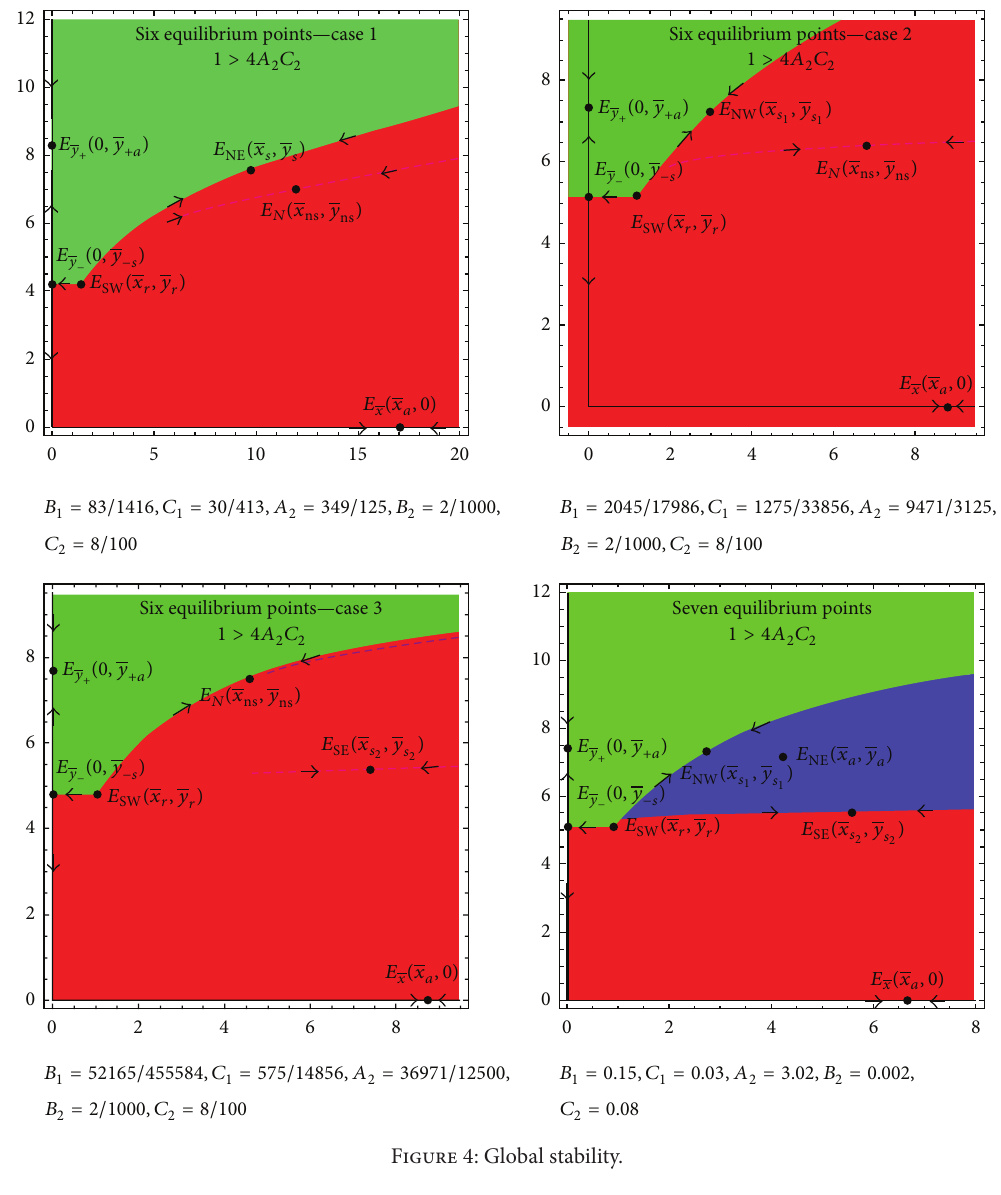
Figure 4: Global